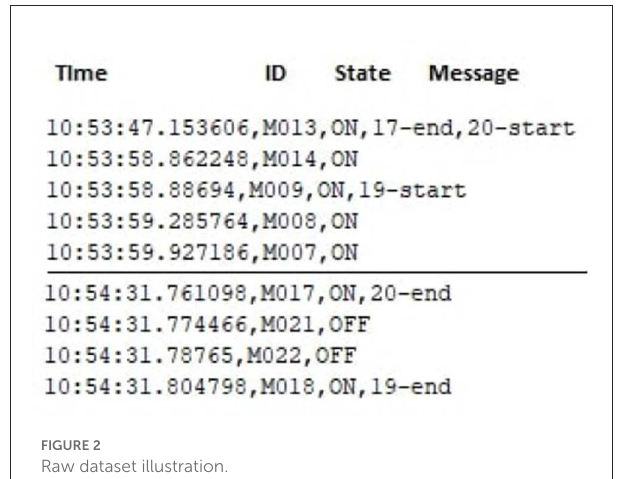
FIGURE2 Raw dataset illustration.